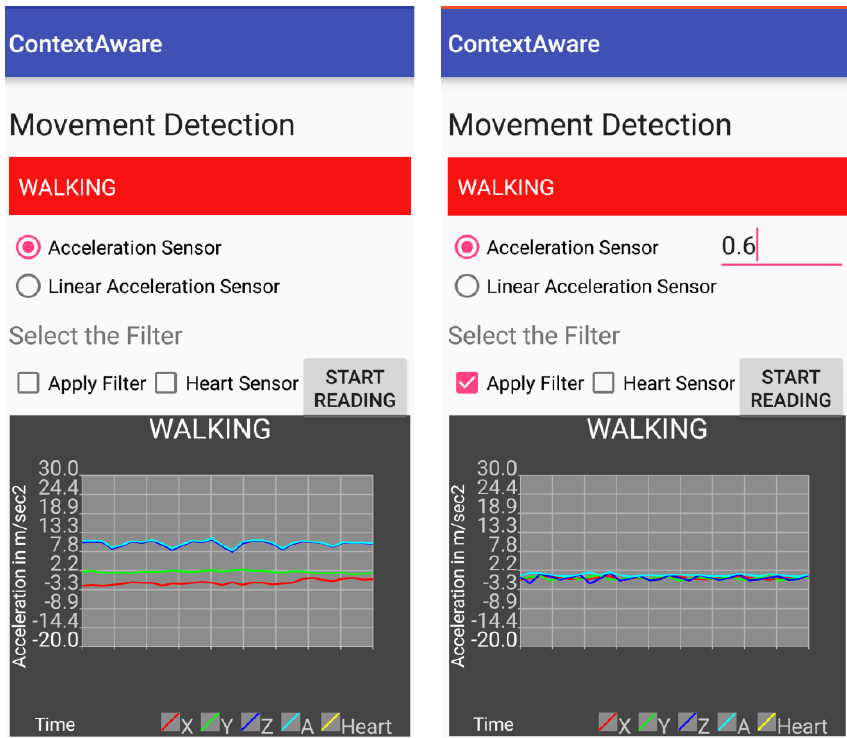
Figure 5. Accelerometer Data for Activity Walking (left without ILPF, right with